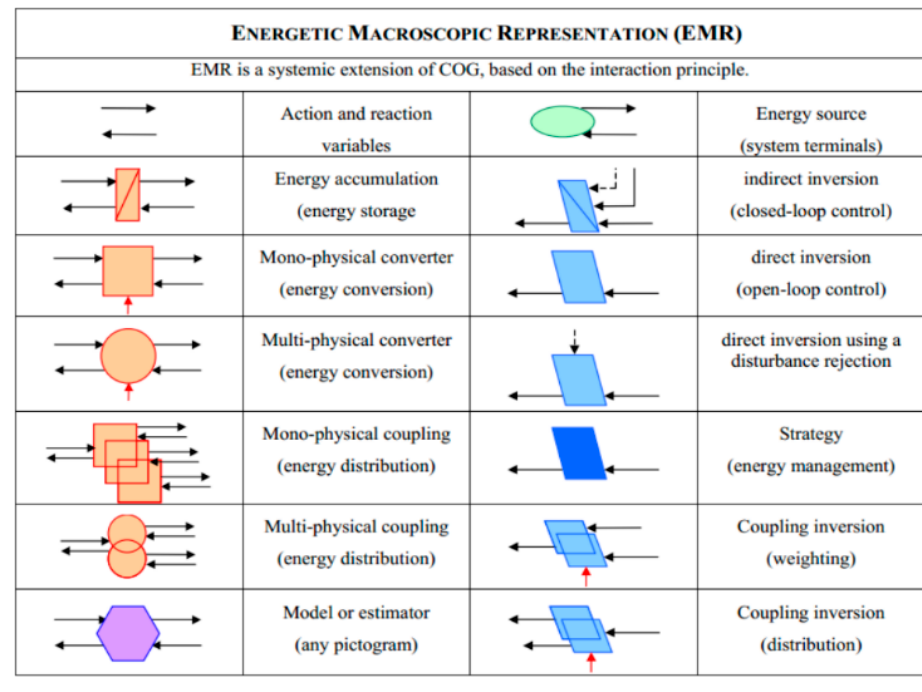
Figure 4. EMR blocks introduction.